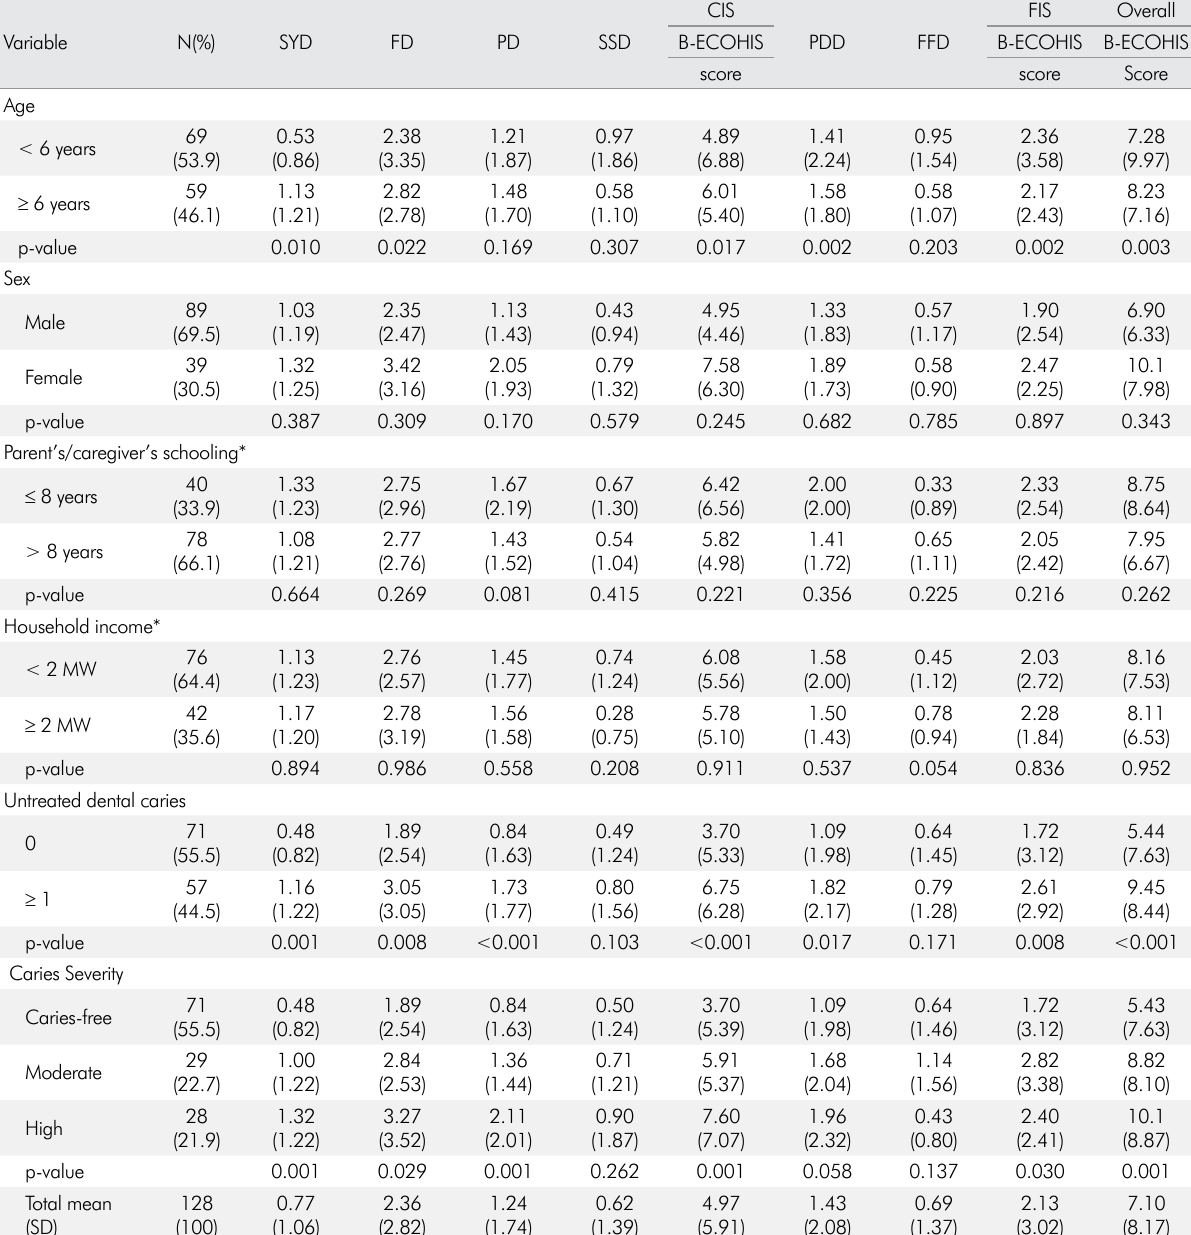
Table 2. Mean scores in B-ECOHIS domains according to socioeconomic factors, characteristics of the children, and oral conditions.